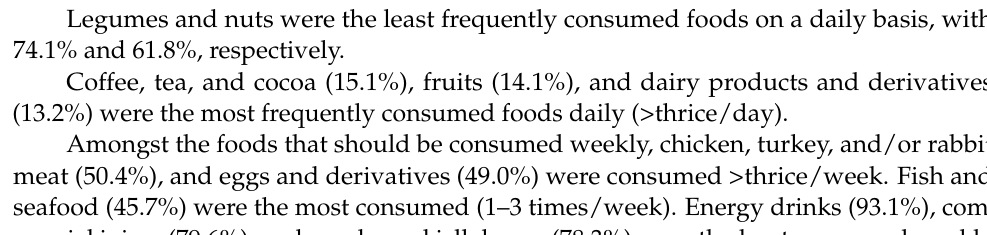
Figure 2. Frequency of consumption. Foods with weekly or occasional recommendations.